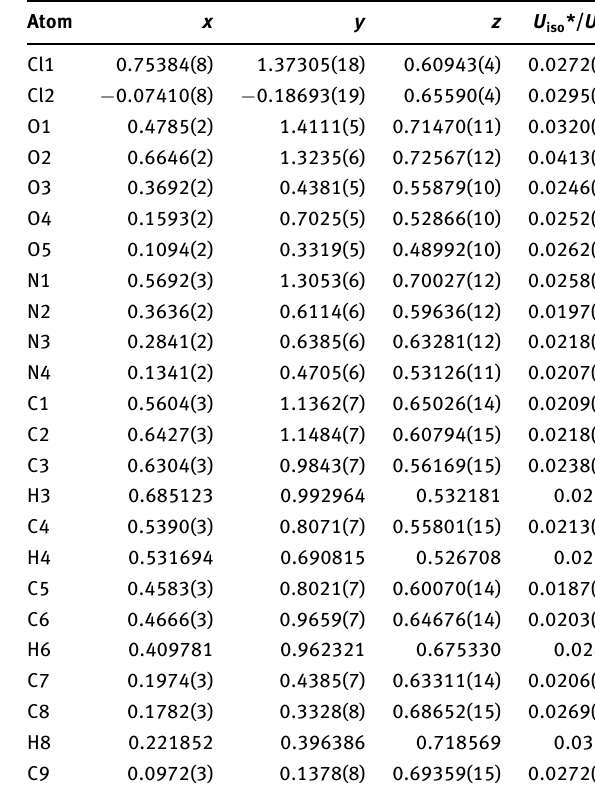
Table 2: Fractional atomic coordinates and isotropic or equivalent isotropic displacement parameters (Å 2